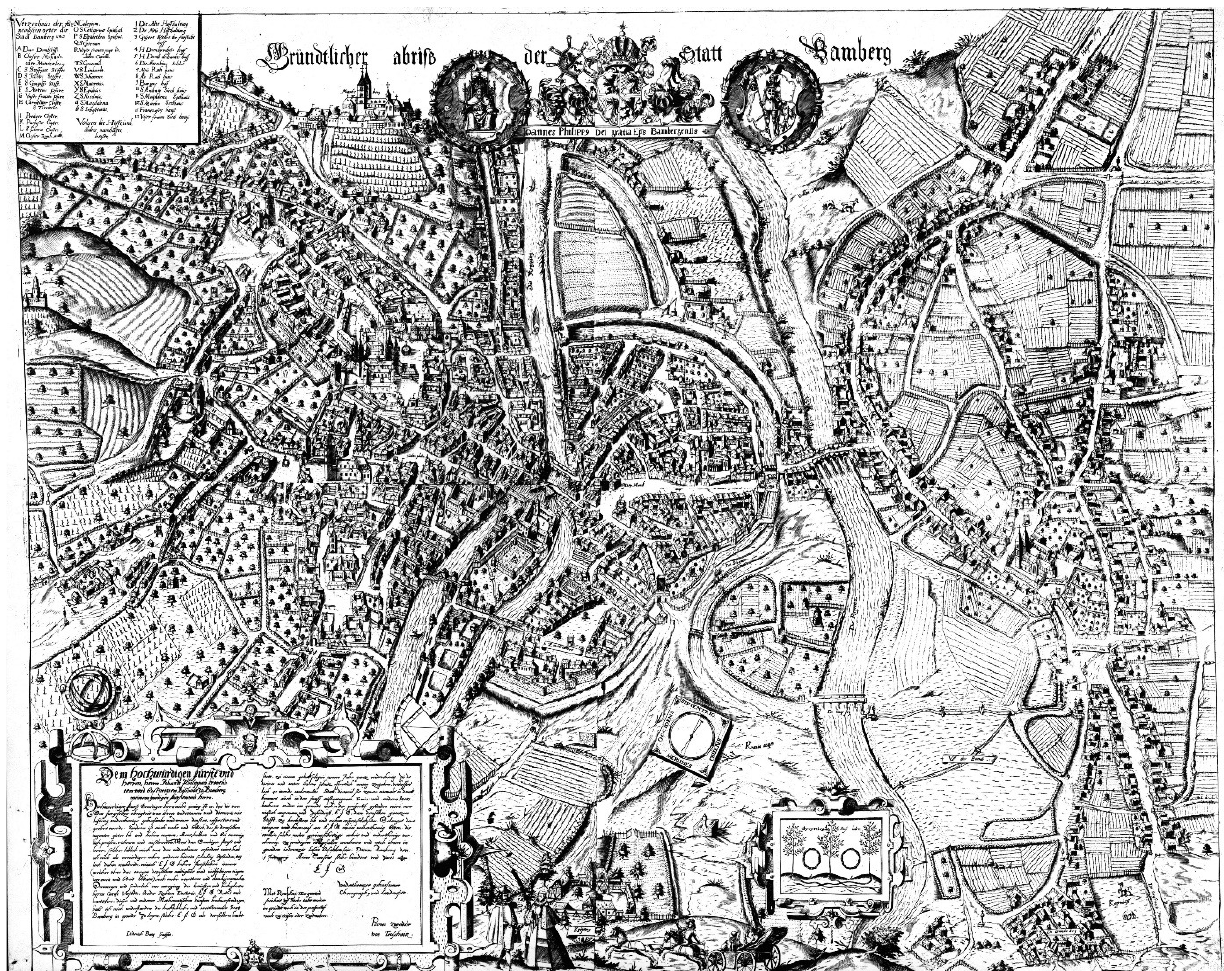
Figure 1. Map of Bamberg by Petrus Zweidler, 1602. Source: Zweidler